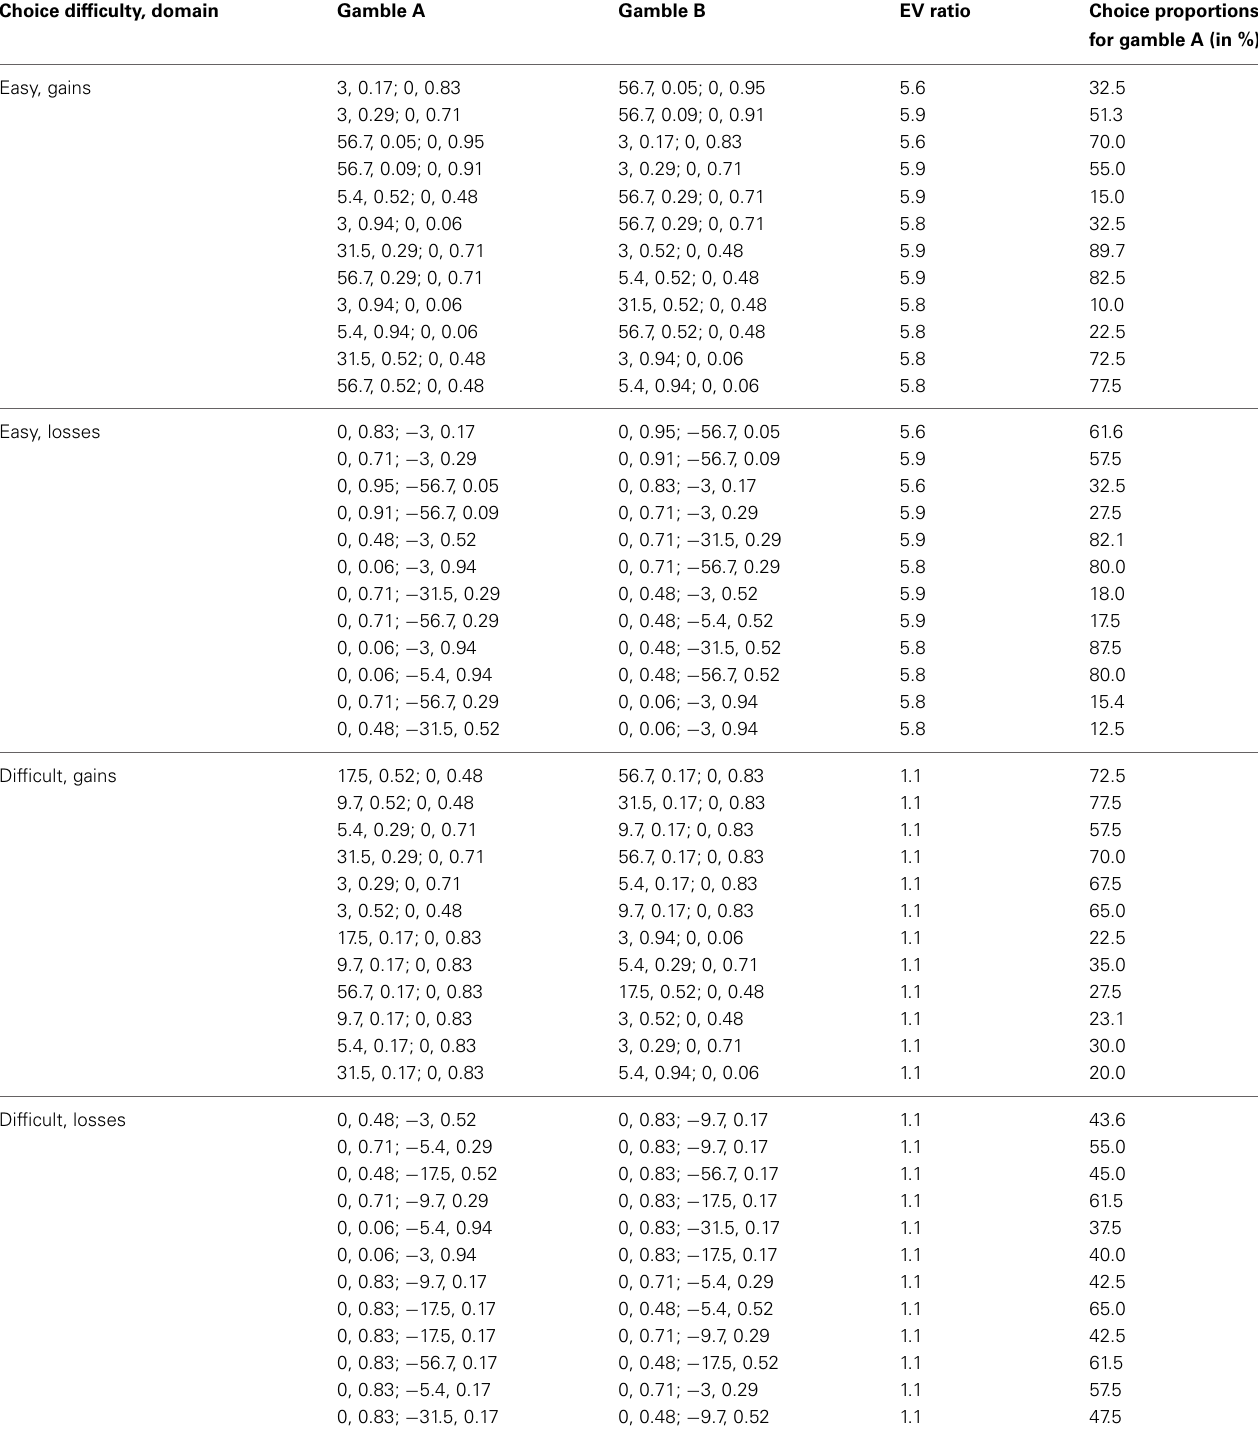
Table D2 | Gamble problems used in Experiment 2 and the obtained choice proportions. Choice difficulty, domain Gamble A Gamble B EV ratio Choice proportions